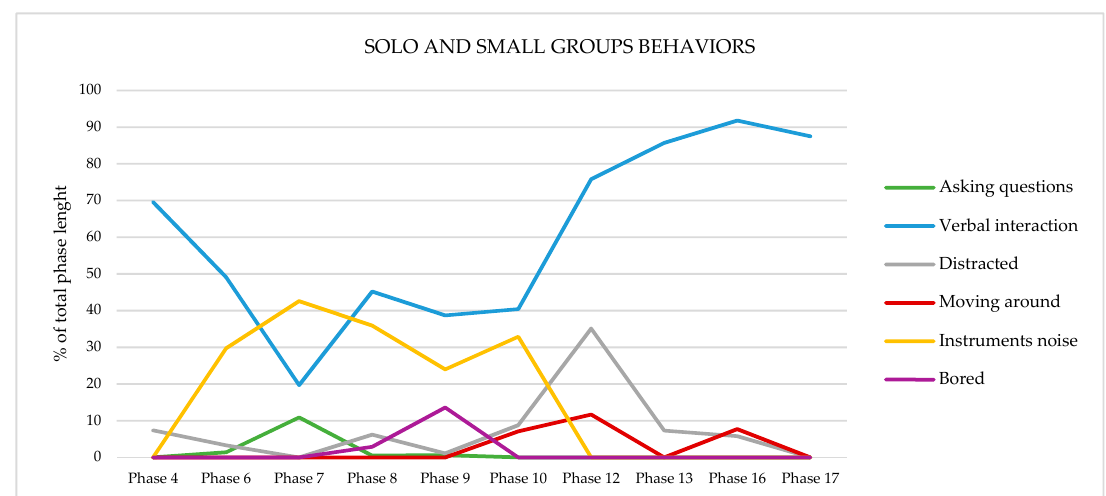
Figure 6. The figure shows the trend of behaviours manifested by at least one or more children.